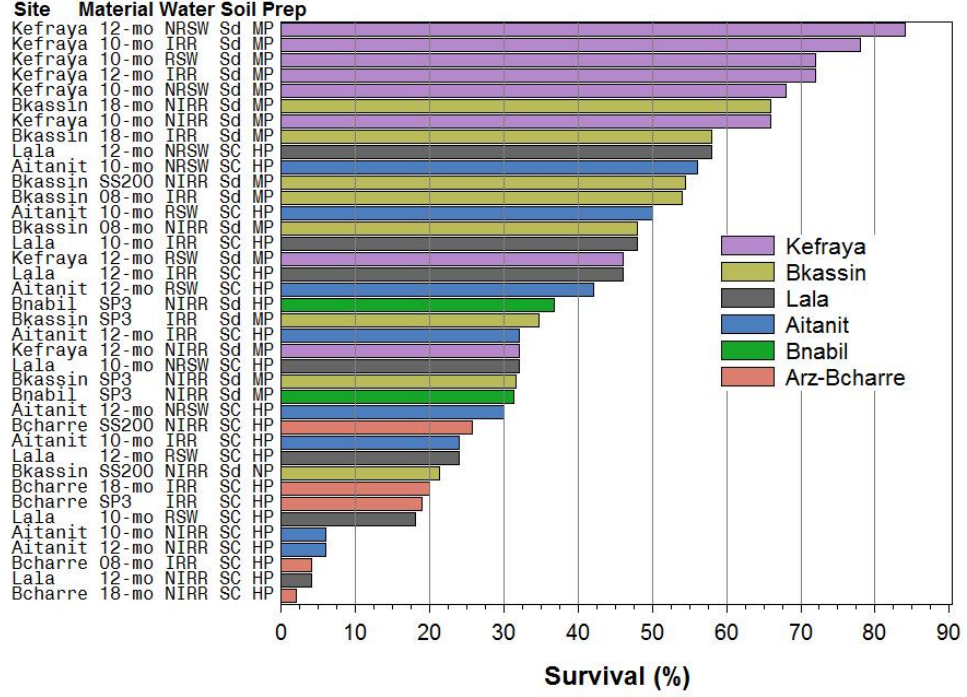
Figure 6. Survival in 42 planting treatment combinations. Not shown are four with zero survival: Lala 10-mo NIRR SC HP, Bcharre 08-mo NIRR SC HP, Bcharre SP3 NIRR SC HP, and Bcharre SS200 NIRR SC NP. Plantings at Arz-Bcharre (Bcharre in figure) were Lebanon cedar; all others were stone pine. Treatment attributes (on y -axis) included those for planting material (8-, 10-, 12-, and 18-month-old seedlings; SS200 = 200 seeds sown in patch; SP3 = 3 seeds planted at points), water supplement (NRSW = non-rechargeable solid water, RSW = rechargeable solid water, IRR = conventional hose irrigation, NIRR = no irrigation), soil texture (Sd = sandy, SC = silt-clay), and soil preparation (MP = mechanical preparation, HP = hand tool preparation, NP = no preparation).